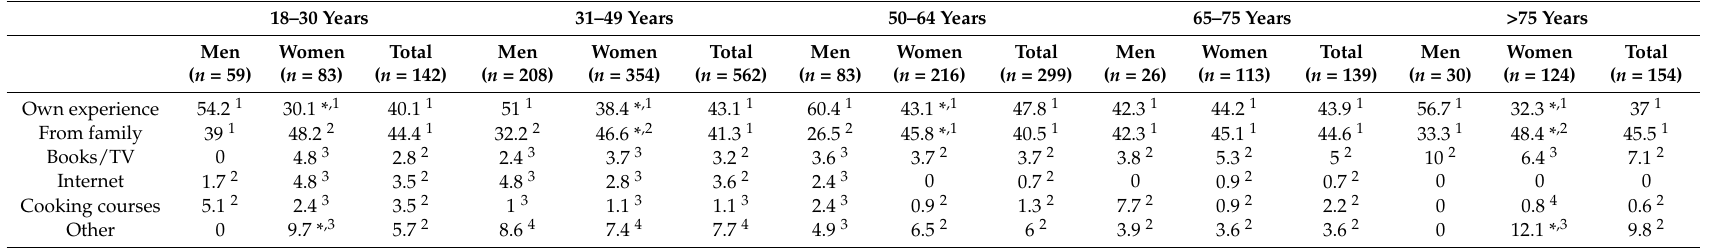
Table 2. Reported methods by which cooking was learned (%) by age and sex.